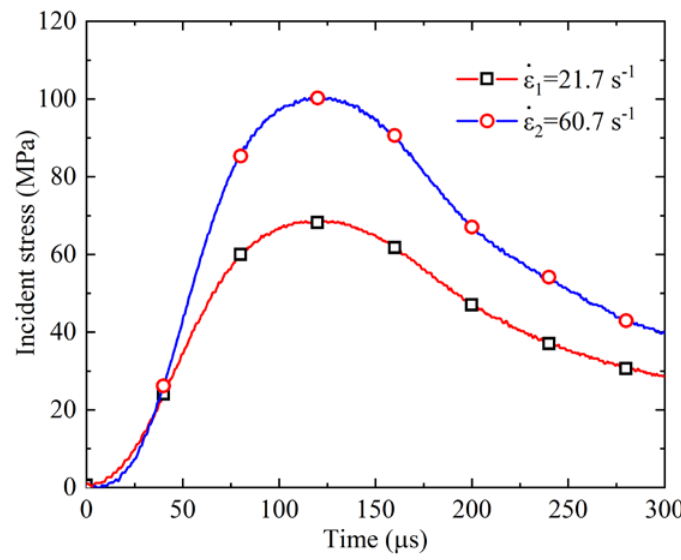
Figure 7. Measured incident stress waves under different impacting velocities, recorded by the strain gauge; line ε 2 has an impact velocity of 4.2 m/s and line 𝜀𝜀 2 ̇